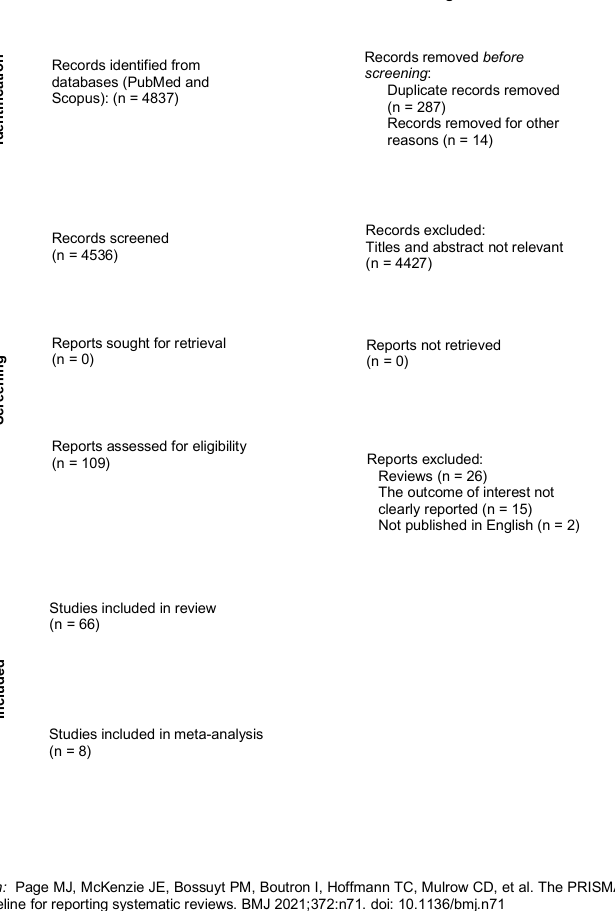
Figure 1. Prisma flow diagram. For more information, visit: http://www.prisma-statement.org/ (accessed on 31 December 2021).